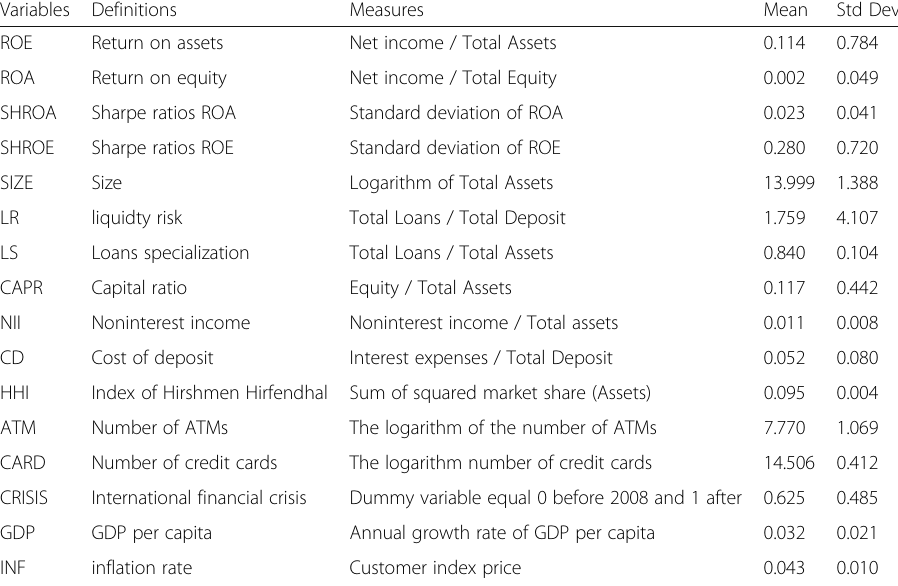
Table 7 Summary statistics and definitions of